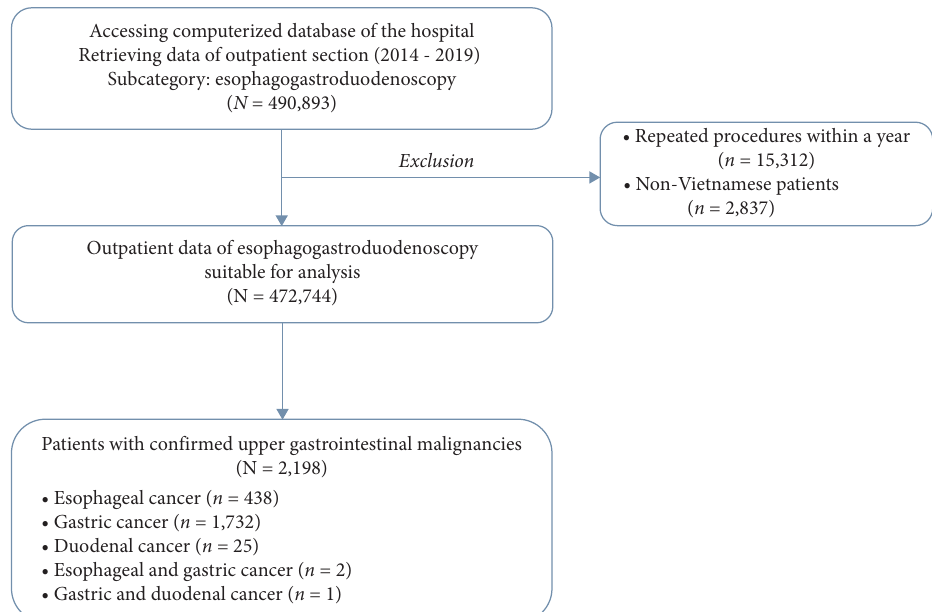
Figure 1: Data retrieval procedures of the